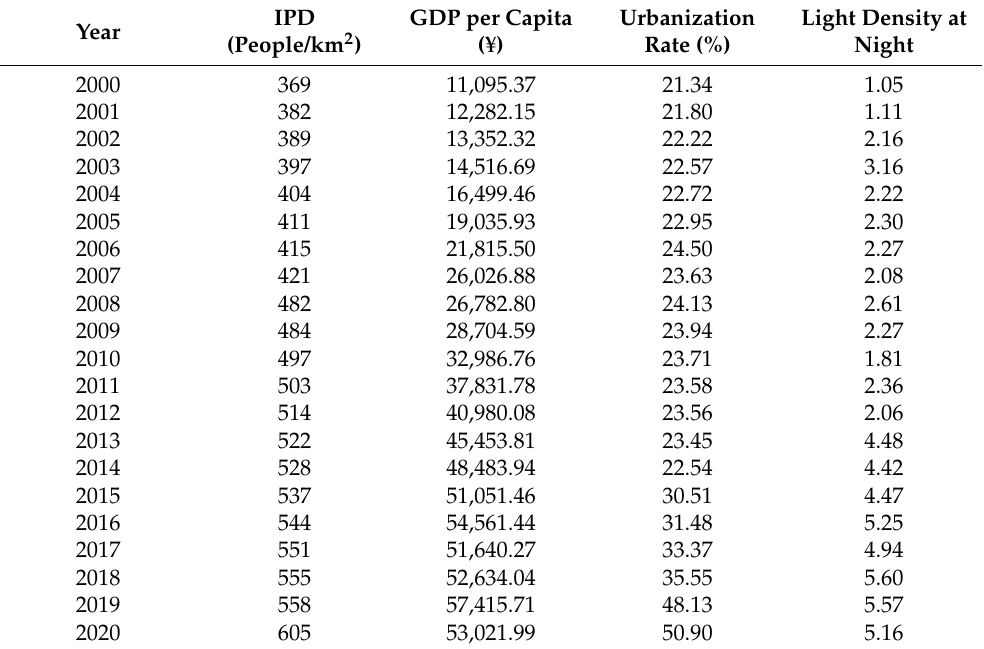
Table 3. Night-time lighting data and historical yearbook statistics. Data sources: Statistics of Guangxi Zhuang Autonomous Region Statistics Bureau from 2000 to 2020 (http://tjj.gxzf.gov.cn/tjsj/tjnj (accessed on 10 September